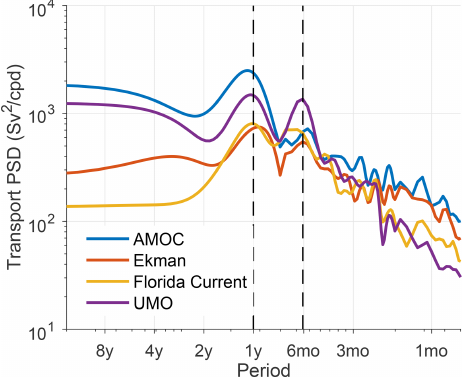
Figure 2. Power spectral density of the AMOC and its component parts as a function of period. The vertical dashed lines highlight the annual and semi-annual